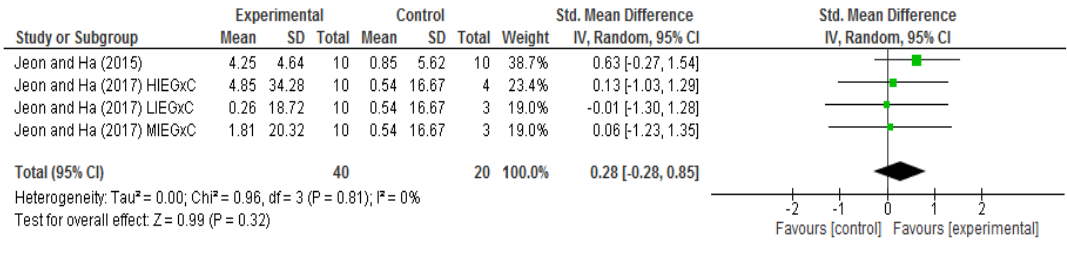
Figure 2. Forest plot of the BDNF levels changes (RCTs). SD = standard deviation; IV = inverse-variance; CI = confidence interval; HIEGxC = high-intensity aerobic exercise group × Control; LIEGxC = Low-intensity aerobic exercise group × Control; MIEGxC = moderate-intensity aerobic exercise group × Control.